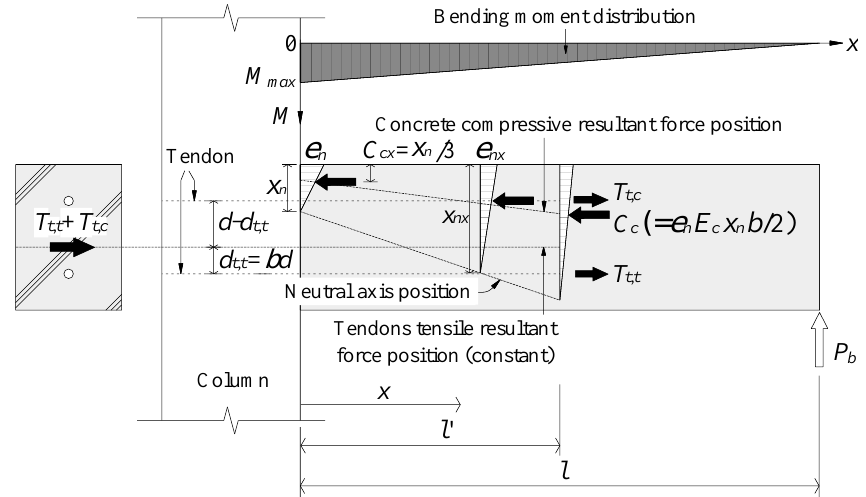
Figure 7. Compressive and tensile resultant forces at arbitrary beam section of PC zone.